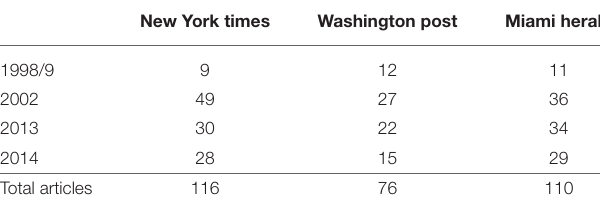
TABLE 1 | Newspaper articles sampled,